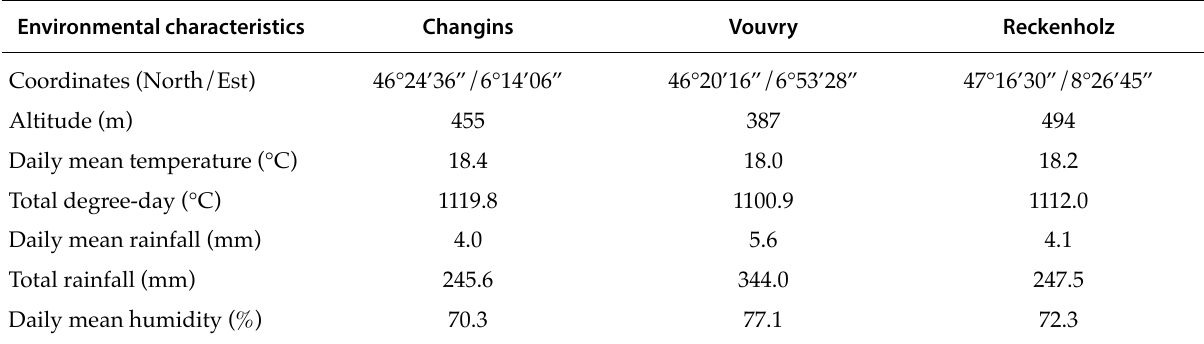
Table 2. Locations and environmental conditions for three field experiment locations (data from 01/06/2014 to 31/07/2014). (source: